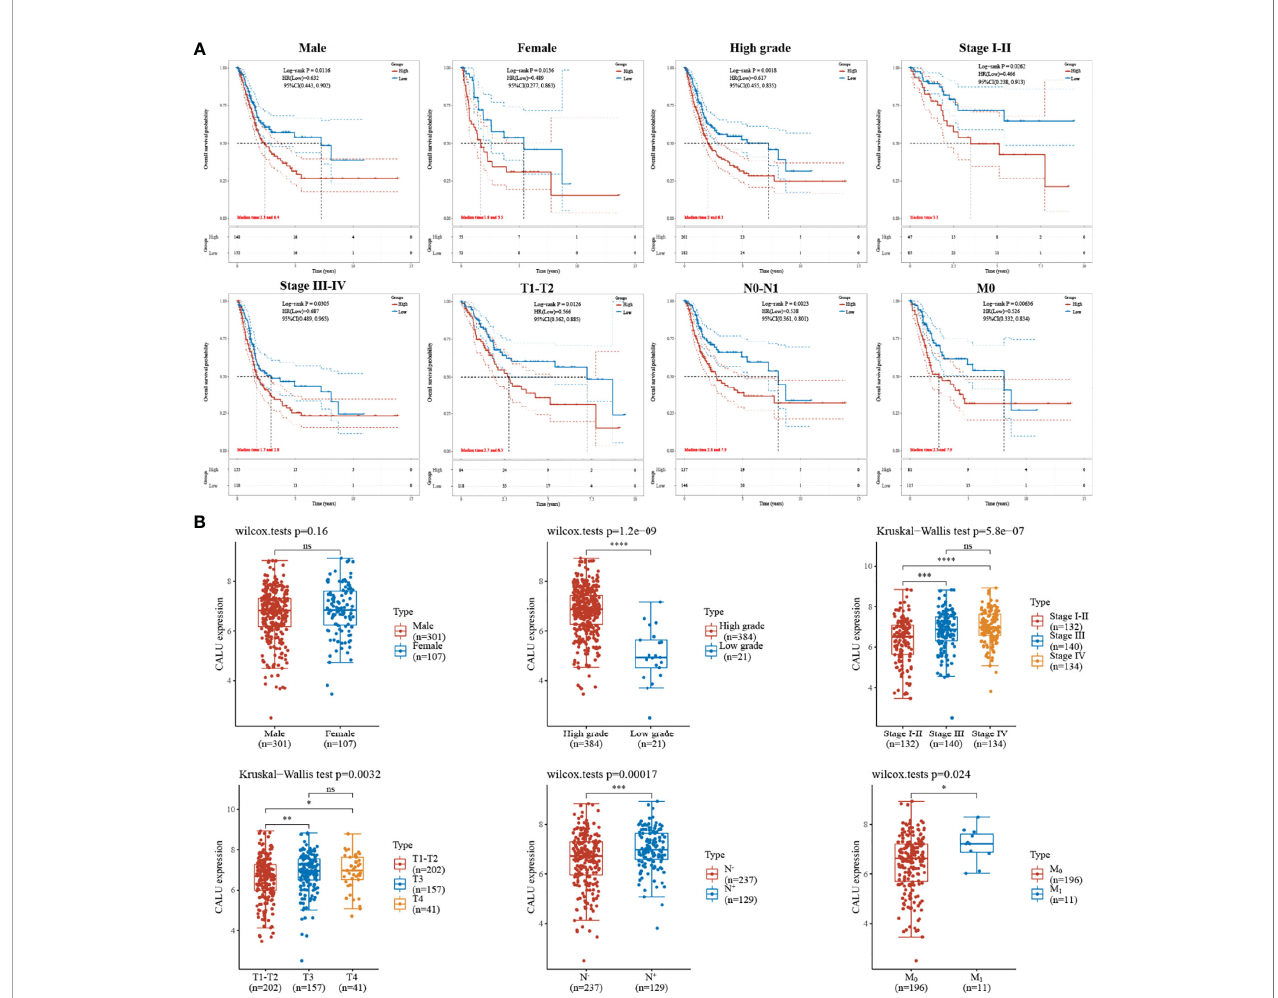
FIGURE 2 | Correlation of CALU with subgroup survival and clinical characteristics. (A) the expression level of CALU altered the OS of BLCA patients in multiple subgroups, including male (p=0.012), female (p=0.014), high grade (p=0.002), Stage I-II (p=0.026), Stage III-IV (p=0.031), T1-T2 (p=0.013), N0-N1 (p=0.002) and M0 (p=0.006). (B) Tumor tissue with higher grade (p<0.001), stage(p<0.001), T (p=0.003), N (p<0.001),M (p=0.024) classi fi cation expressed higher CALU. ****p<0.0001, ***p<0.001, **p<0.01, *p<0.05. NS, not signi fi